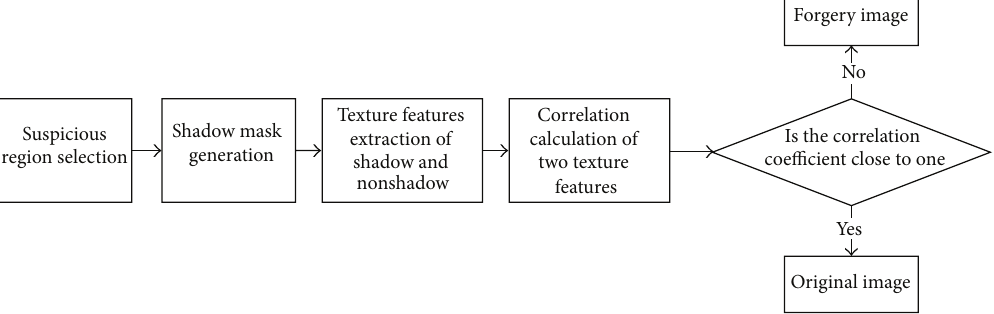
Figure 2: Image forgery detection method based on texture consistency of shadow.